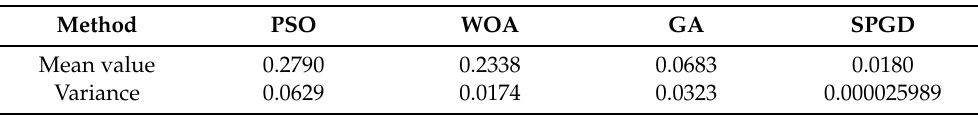
Table 4. The mean values and variances of relative error in 10 experiments in different methods when µ =